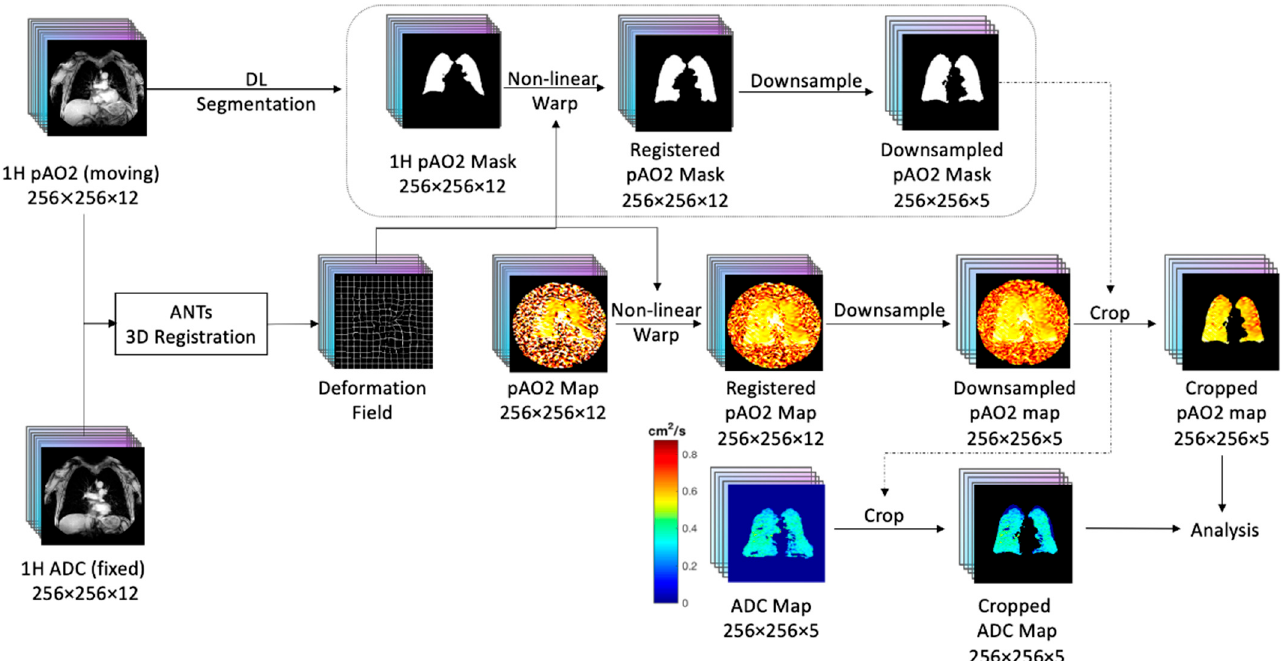
Figure 1. Workflow for the lung MRI co-registration between different breath stages .